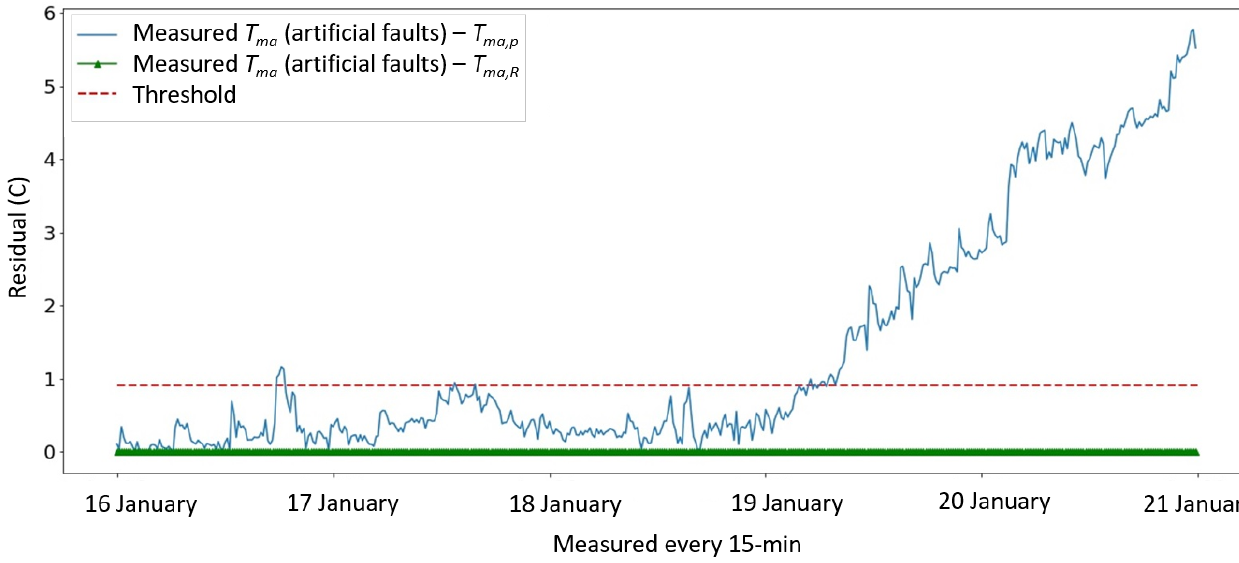
Figure 13 . Residual between measurements of T ma and predictions of T ma .